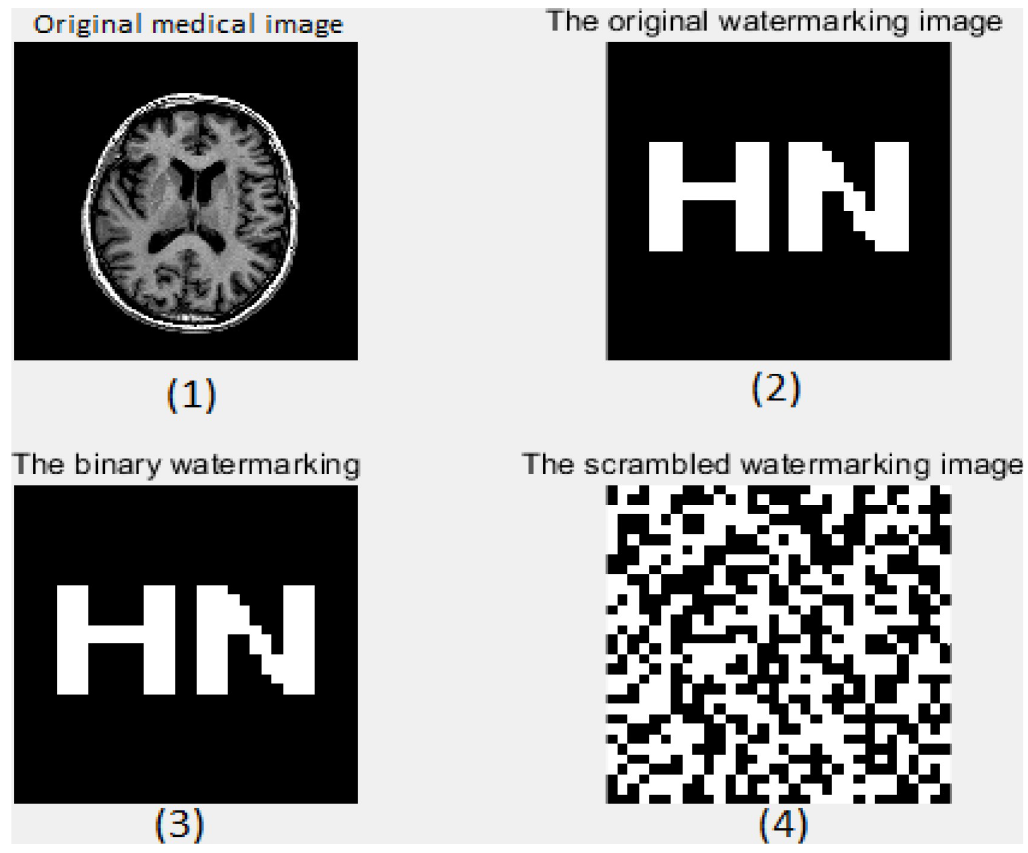
Fig 9. Original image and watermark